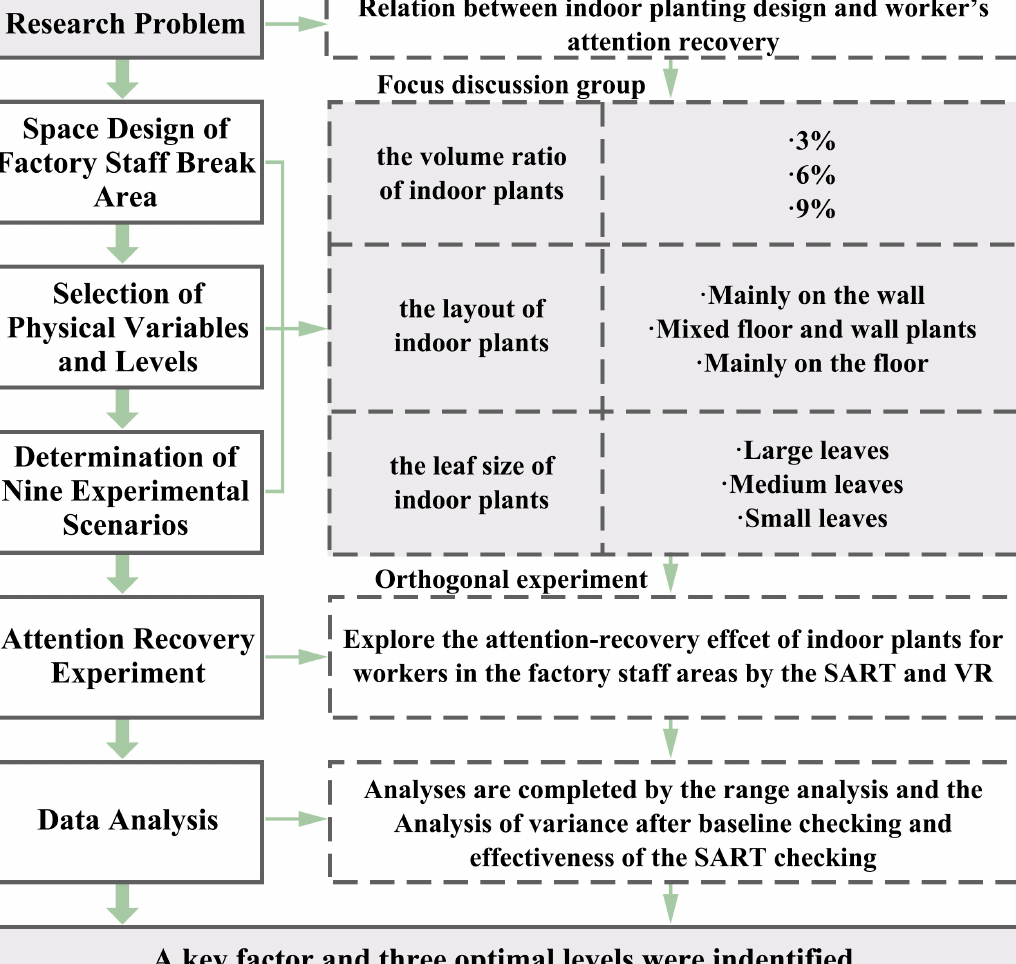
Figure 1. Research Framework.